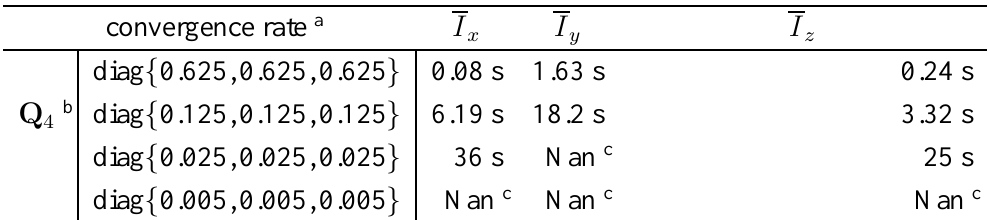
Table 3. Different weighting matrices result in different convergence